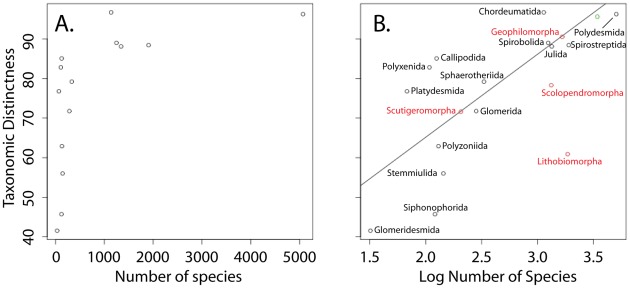
Taxonomic distinctness plots for the ordinal taxa of the Diplopoda.Plot A shows taxonomic distinctness in relation to the species diversity of the ordinal groups. Plot B shows the same relationship as the previous plot with species diversity log transformed and a best fit line obtained via linear regression (r2 = 0.5705, P<0.01; does not include the two millipede orders with only two species). Points representing the orders of the Chilopoda (shown in red; does not include the single species order Craterostigmomorpha) and the Pseudoscorpiones (shown in green) were added after the regression analyses and have no bearing on the best fit line.